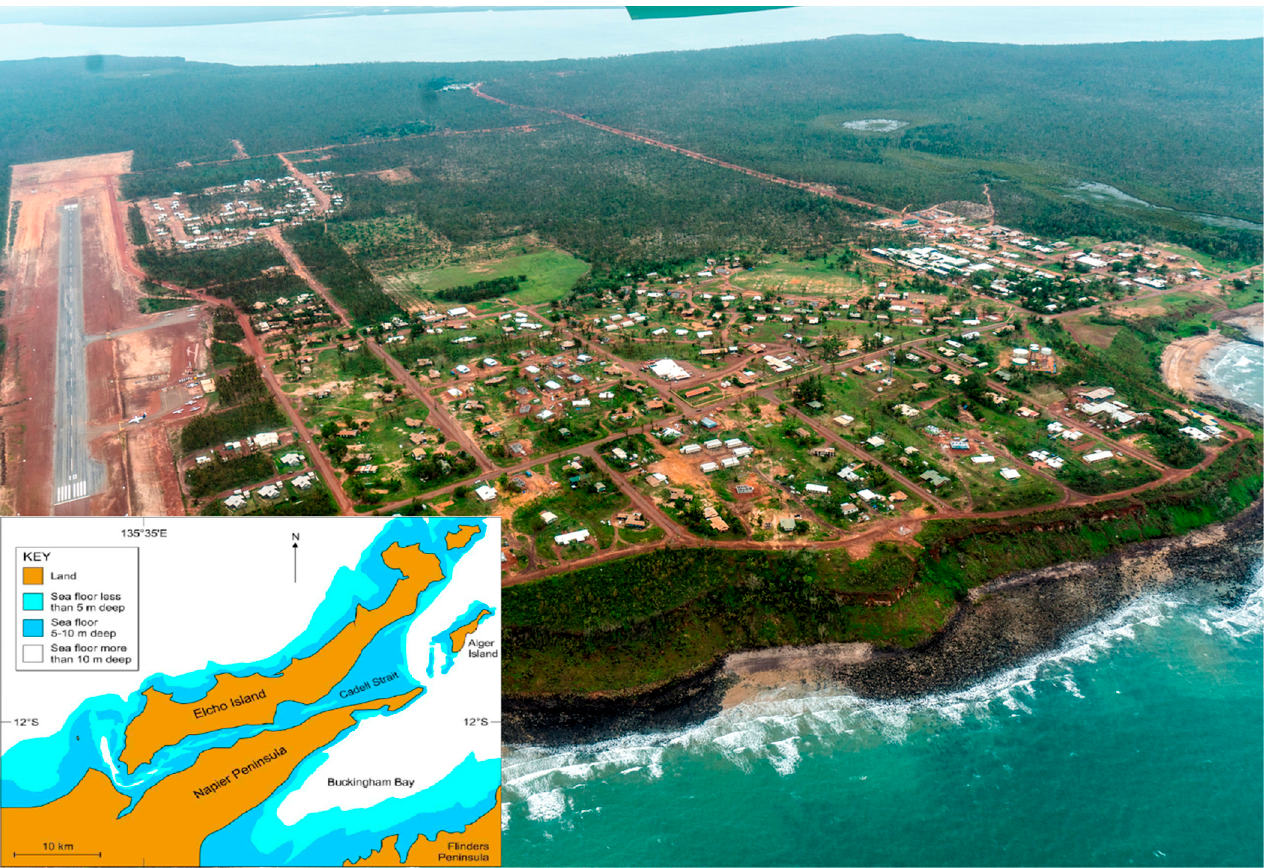
Figure 1. Galiwin’ku (source: https://www.eastarnhem.nt.gov.au/galiwinku) .